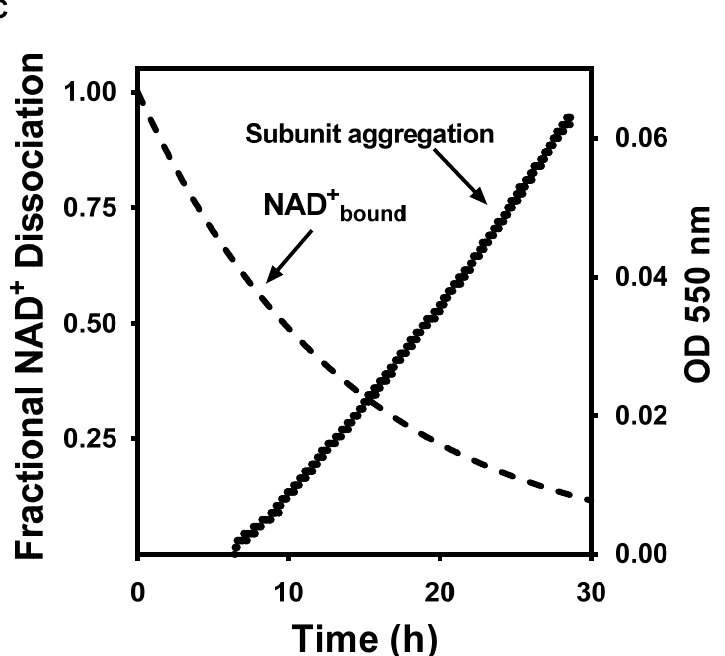
Figure 5. ( A – C ) Temporal dissociation between H 2 O 2 − mediated loss of r − GAPDH enzyme activity, NAD + dissociation, and subunit aggregation. ( A ) Comparison between time − dependent DTT − irreversible GAPDH activity enzyme activity and dissociation of NAD + from H 2 O 2 − oxidized r − GAPDH over 1350 s at 14 ◦ C) ( B ) NAD + dissociation for 150 min at 14 ◦ C in control and H 2 O 2 − oxidized r − GAPDH, modeled to a limited first − order protein unfolding process. The similarity of the resulting rate constant to that obtained in Figure 4b indicates that both exposure to buried cysteines and NAD + dissociation arise from subunit unfolding after H 2 O 2 oxidation. ( C ) r − GAPDH aggregation over 30 h at 14 ◦ C. The data show that H 2 O 2 irreversible GAPDH enzyme inactivation, subunit unfolding, and subunit aggregation are temporally distinct.